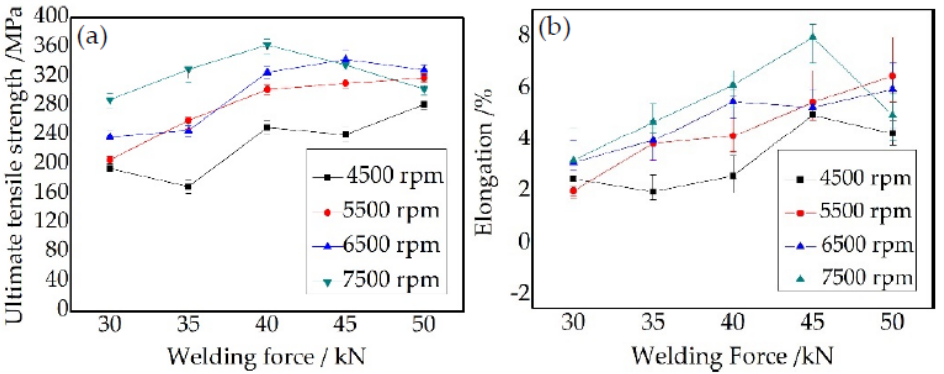
Figure 8. Tensile property of A1–D5 joints: ( a ) UTS and ( b ) elongation.